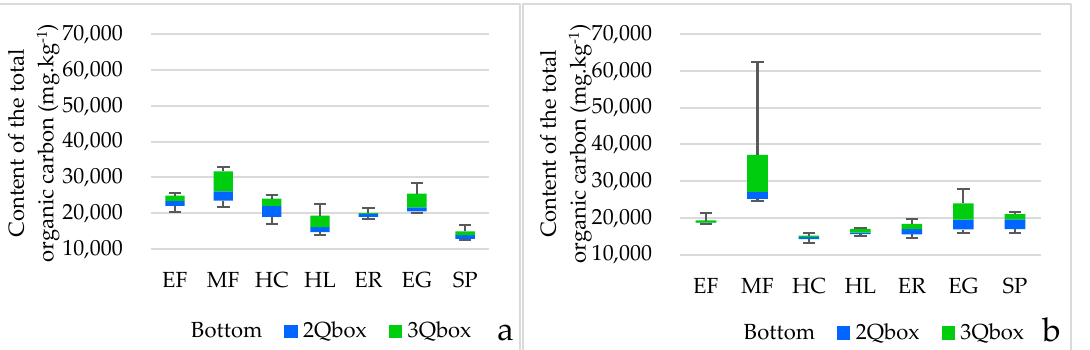
Figure 3. Differences (mg · kg − 1 ) in total organic carbon content of soils in ( a ) reduced tillage and ( b ) conventional tillage systems; EF: Eutric Fluvisol; MF: Mollic Fluvisol; HC: Haplic Chernozem; HL: Haplic Luvisol; ER: Eutric Regosol; EG: Eutric Gleysol; SP: Stagnic Planosol. Error bars represent maximum and minimum values.